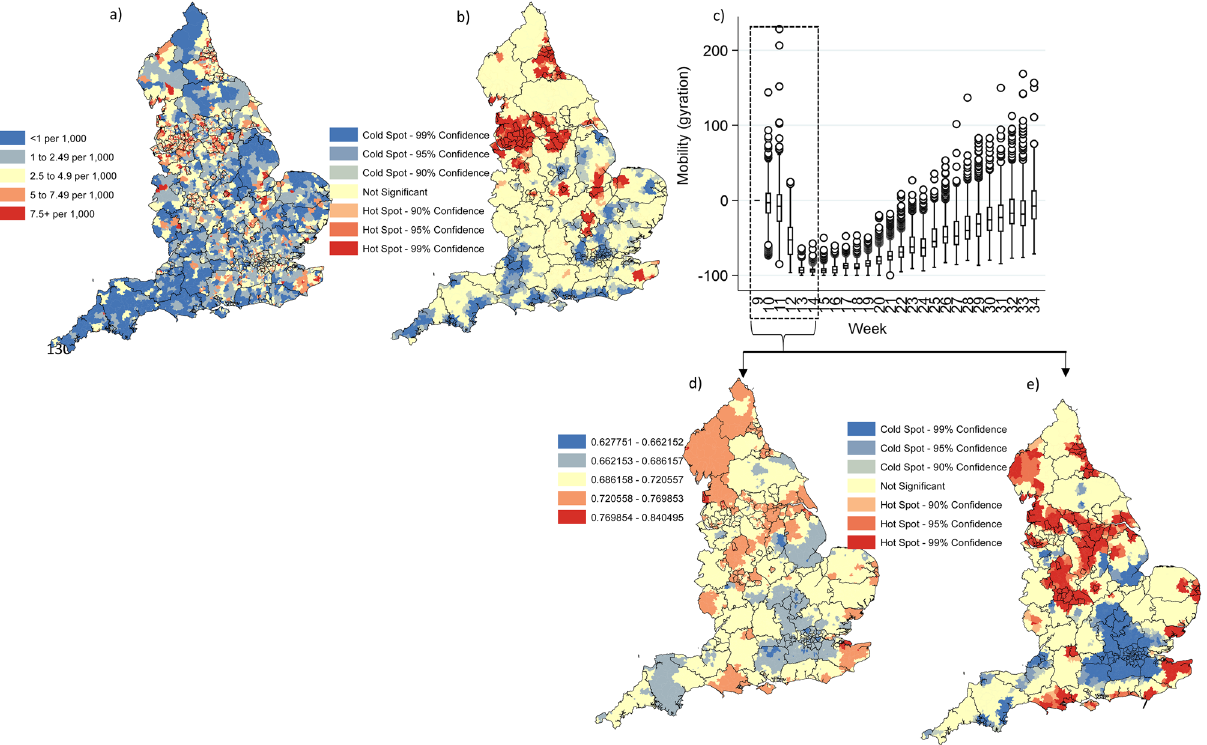
Figure 1. ( a ) cumulative case rates at week 34 at English MSOA level (N = 6791); ( b ) statistically significant localised hot and cold spots for higher and lower cumulative COVID-19 cases at MSOA resolution at week 34 of 2020 using the Getis-Ord Gi* localised clustering statistic; ( c ) Box plot of mobility by MSOA and week; ( d ) cumulative mobility loss (darker red indicates lower mobility loss) by MSOA in England (n = 6791) from week 9 to 14 of 2020; ( e ) statistically significant localised hot and cold spots for higher and lower cumulative mobility loss at MSOA resolution from week 9 to 14 of 2020 using the Getis-Ord Gi* statistic. Maps constructed using ArcGIS 10.5 (https:// deskt op. arcgis. com/